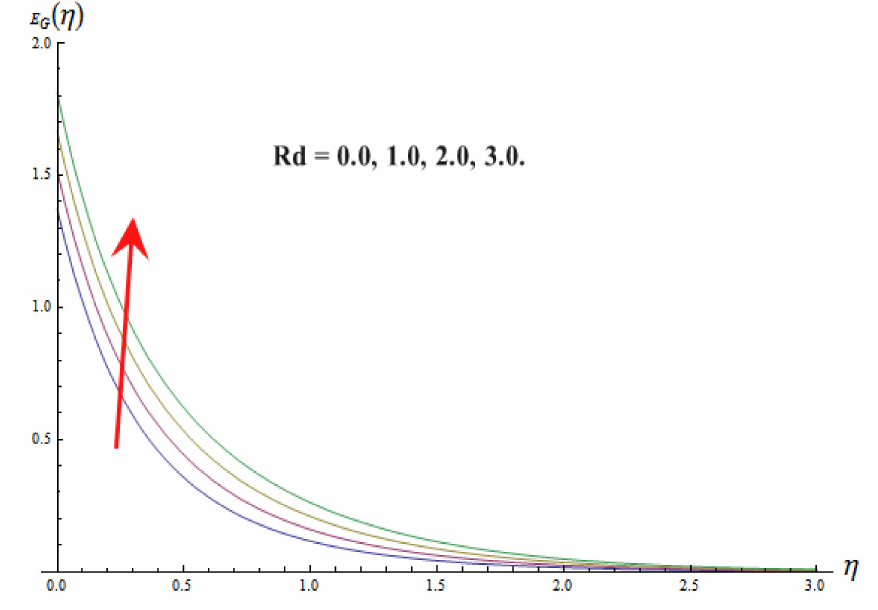
Figure 14. Impact of Rd on E G ( η ) keeping Γ = 0.5, Ha = 0.2, Br = 2, λ = 2, Ec = 0.2, Pr = 0.5, β 1 = 0.2, λ 1 = 0.2, K ∗ =